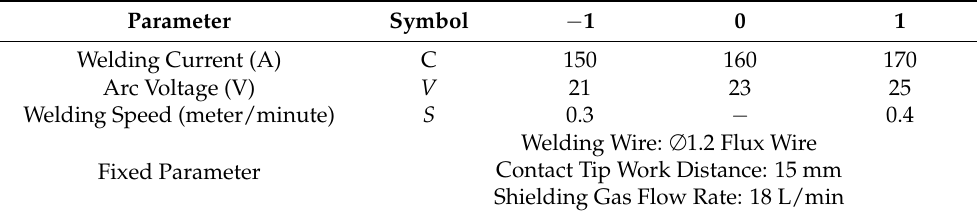
Figure 2. A schematic diagram of bead geometry. Table 3. Flux-cored arc welding variables and their levels.